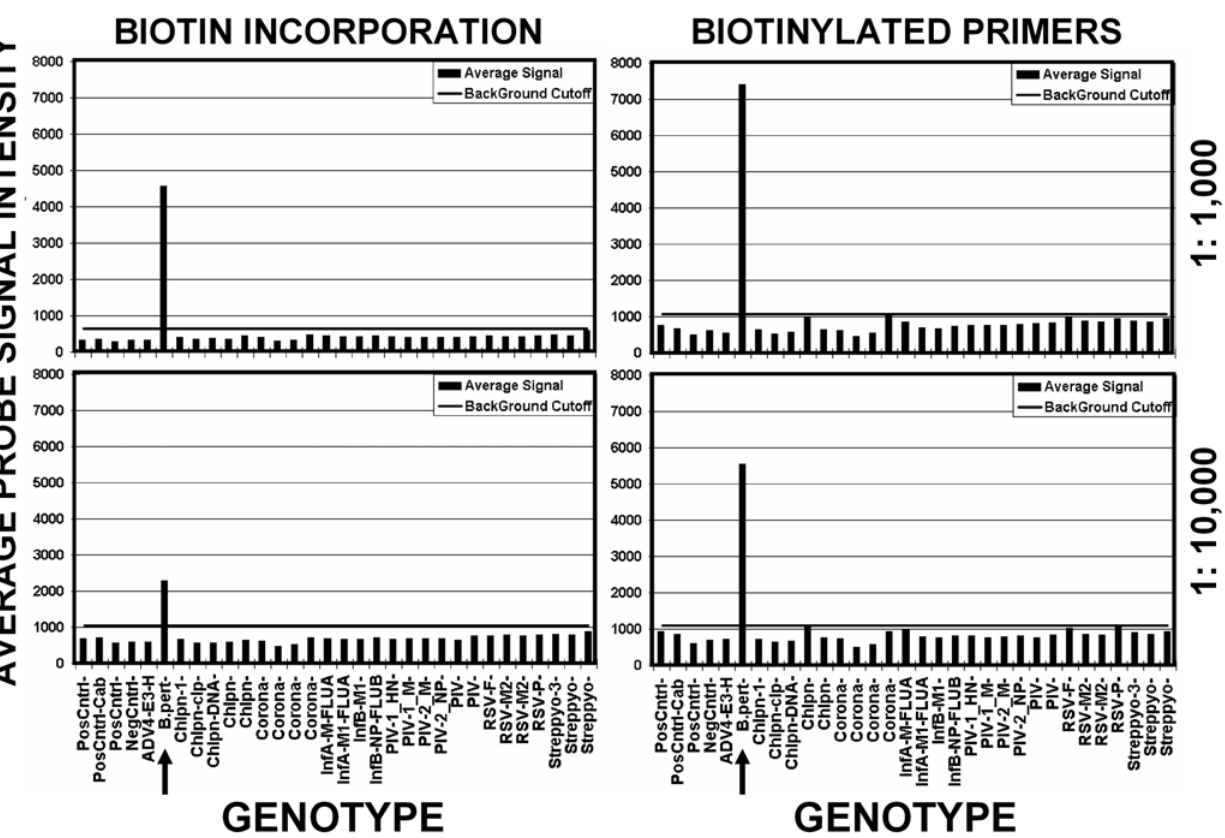
Figure 2. Comparison of assay sensitivity with target labeled by biotin-incorporation and biotinylated primers. B. pertussis ( B.pert , arrow) genomic DNA at 15 ng/ul was diluted to 1:1,000 (top panels) and 1:10,000 (bottom panels) and labeled either by biotin-incorporation (left panels) or with biotinylated reverse primers (right panels). The average of type-specific probe group signals in picoamps is shown at the left and identity of pathogen type-specific probe groups is shown below panels. The horizontal bar indicates the assay cutoff, which was determined by the mean value of negative control probes plus 3 standard deviations of the mean.